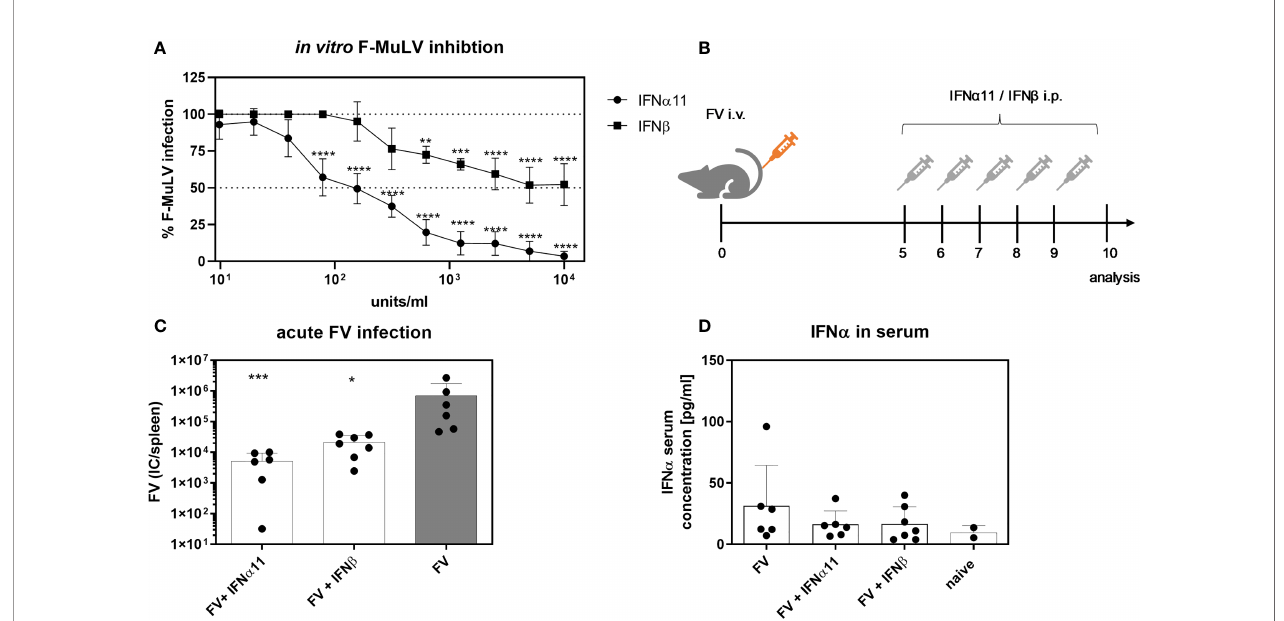
FIGURE 1 | Antiretroviral activity of IFN a 11 and IFN b during acute FV infection. (A) Antiretroviral activity of IFN a 11 and IFN b in vitro . Mus dunni cells were treated in vitro with increasing concentrations of IFN a 11 and IFN b (9.76 -10,000 units/ml). Cells were infected with 250 FFU/ml of F-MuLV, cultivated for 3 days, fi xed with ethanol, stained with F-MuLV envelope-speci fi c antibody 720 and foci were counted. F-MuLV titers were normalized to untreated controls as % infection and are shown as mean +SEM (n=4). Statistically signi fi cant differences between the unstimulated cells (100% infection) and the groups of IFN-stimulated cells (IFN a 11 or IFN b ) were tested using Two-way ANOVA and Sidak multiple comparison and are indicated by ** for p < 0.01, *** for p < 0.001, **** for p < 0.0001. (B) The scheme of the experimental timeline is shown. C57BL/6 mice were infected with 20,000 SFFU of FV from day +5 to +9 days post infection were treated daily with 8000 units of IFN a 11 or IFN b . Ten dpi, viral loads were analyzed by an infectious center assay (C) and serum IFN a concentrations (D) were determined by ELISA. Six mice per FV-infected and IFN a 11-treated group and 7 mice per IFN b -treated group were analyzed and the mean values for each group are indicated by a bar (+SEM). Data were pooled from two independent experiments with similar results. Statistically signi fi cant differences between the control group (FV) and the groups of IFN-treated mice (FV + IFN a 11 or FV + IFN b ) were tested using Kruskal-Wallis one-way and Dunn ’ s multiple comparison and are indicated by * for p < 0.05, *** for p <